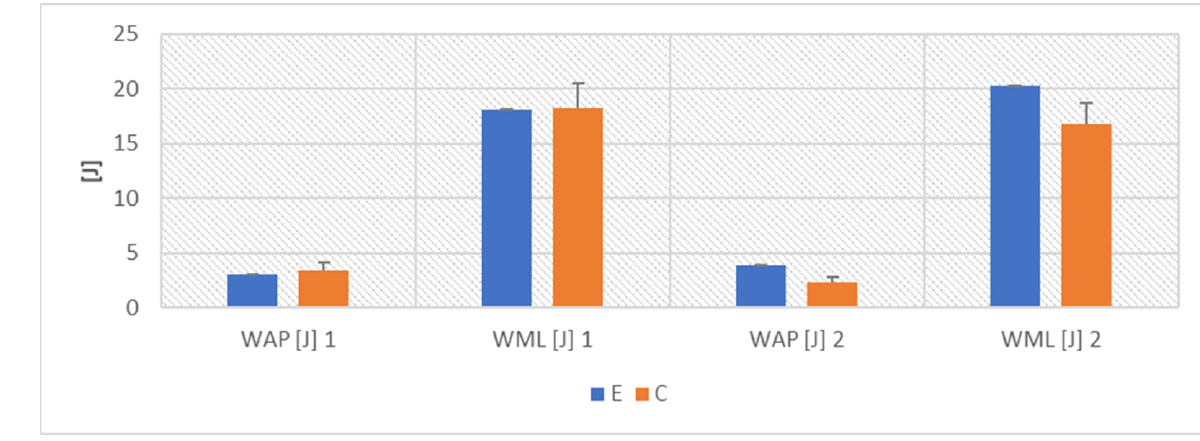
Figure 2. Mean values ± SD of COM work.